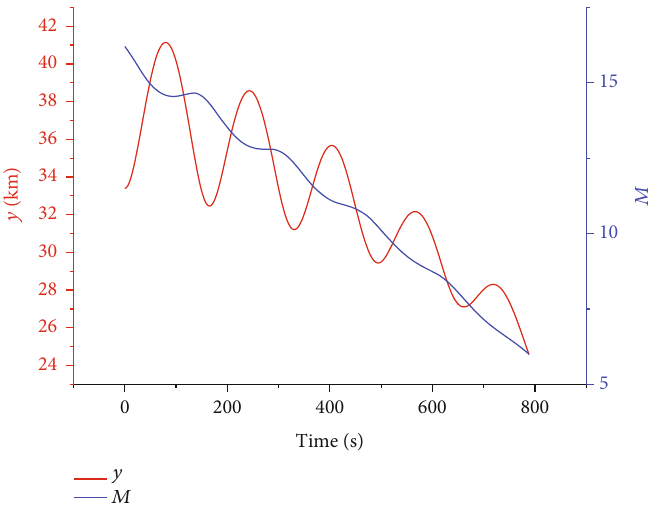
Figure 4: Altitude and Mach number with constant optimal angle of attack.